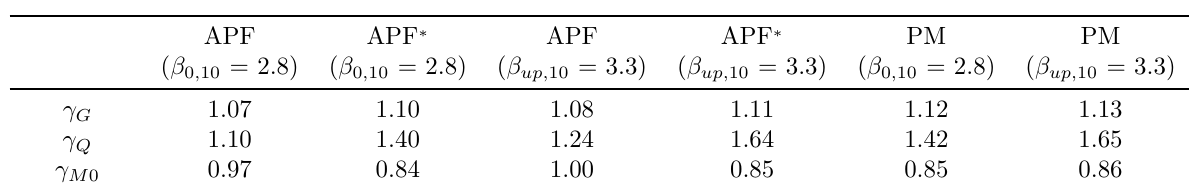
Table 2. Comparison of partial factors ( χ = 0.8).